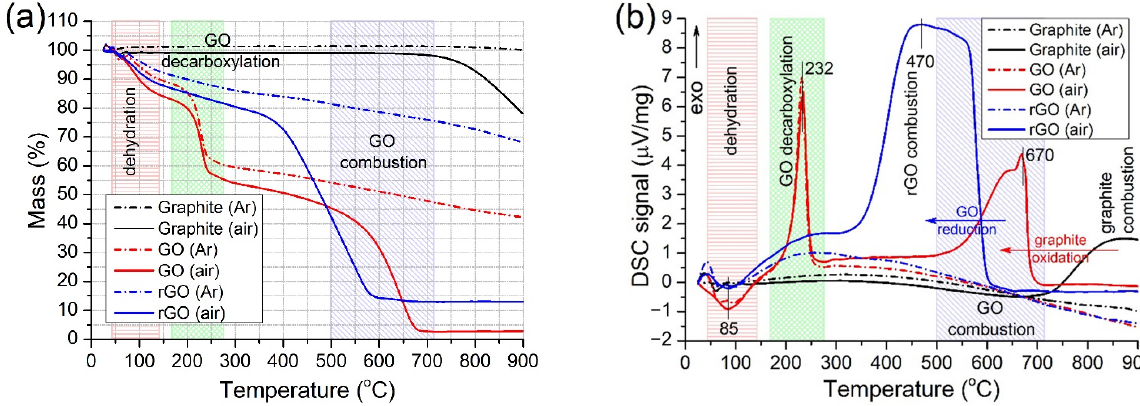
Figure 2. TGcurves( a )andDSCprofiles( b )ofgraphite, Figure 2. TG curves ( a ) and DSC profiles ( b ) of graphite, GO, and rGO samples in air and argon atmospheres.